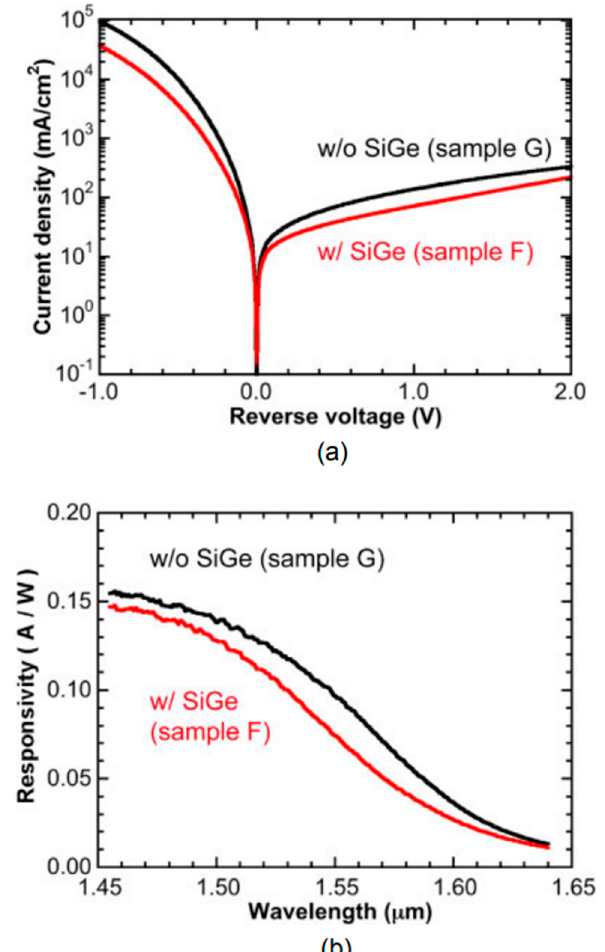
Figure 56. ( a ) Typical I-V characteristics without illumination; ( b ) responsivity spectra biased at 3 V (w/o SiGe and w/SiGe indicate without SiGe and with SiGe, respectively). Reproduced with permission from [126], IOP Publishing, 2016.